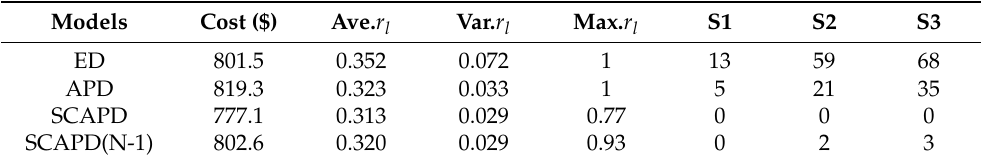
Table 2. Comparison of the pre-contingency and post-contingency power flow distributions for different models tested on the IEEE 30-bus